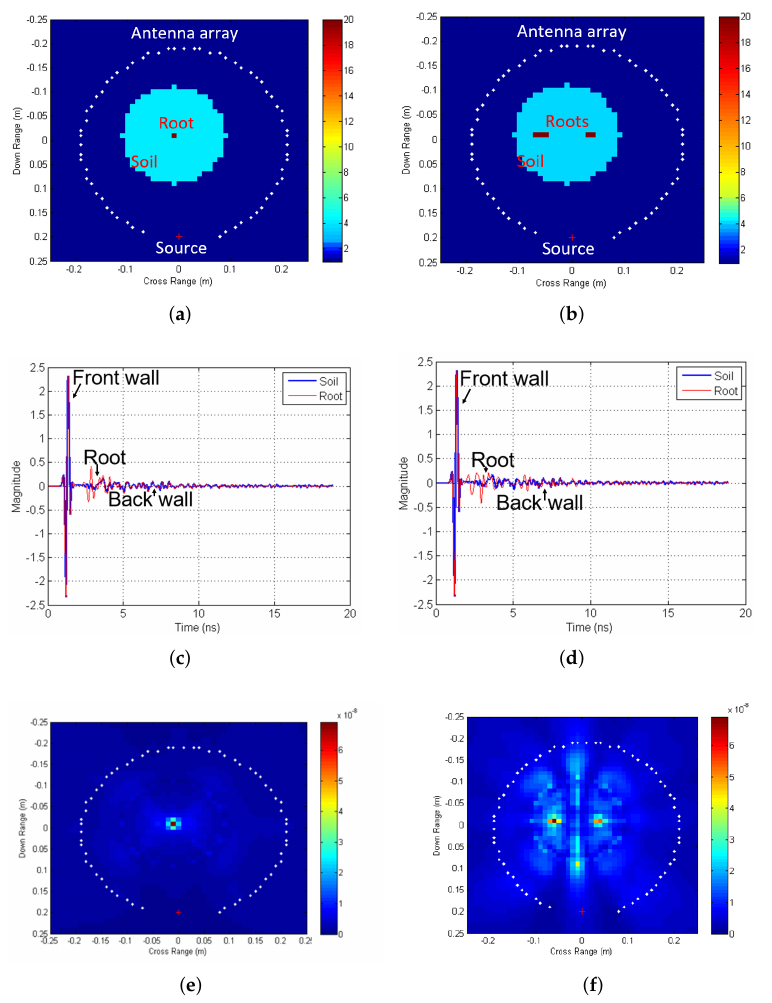
Figure 2. Time reversal simulation results for single and multiple root showing ( a , b ) model schematic with permittivity distribution for single and two roots. ( c , d ) Forward scattered signals for receiver 30 (highlighted with + in Figure 2a,b for single and two roots. ( e , f ) Time-integrated energy images detect the presence of roots for single and two root